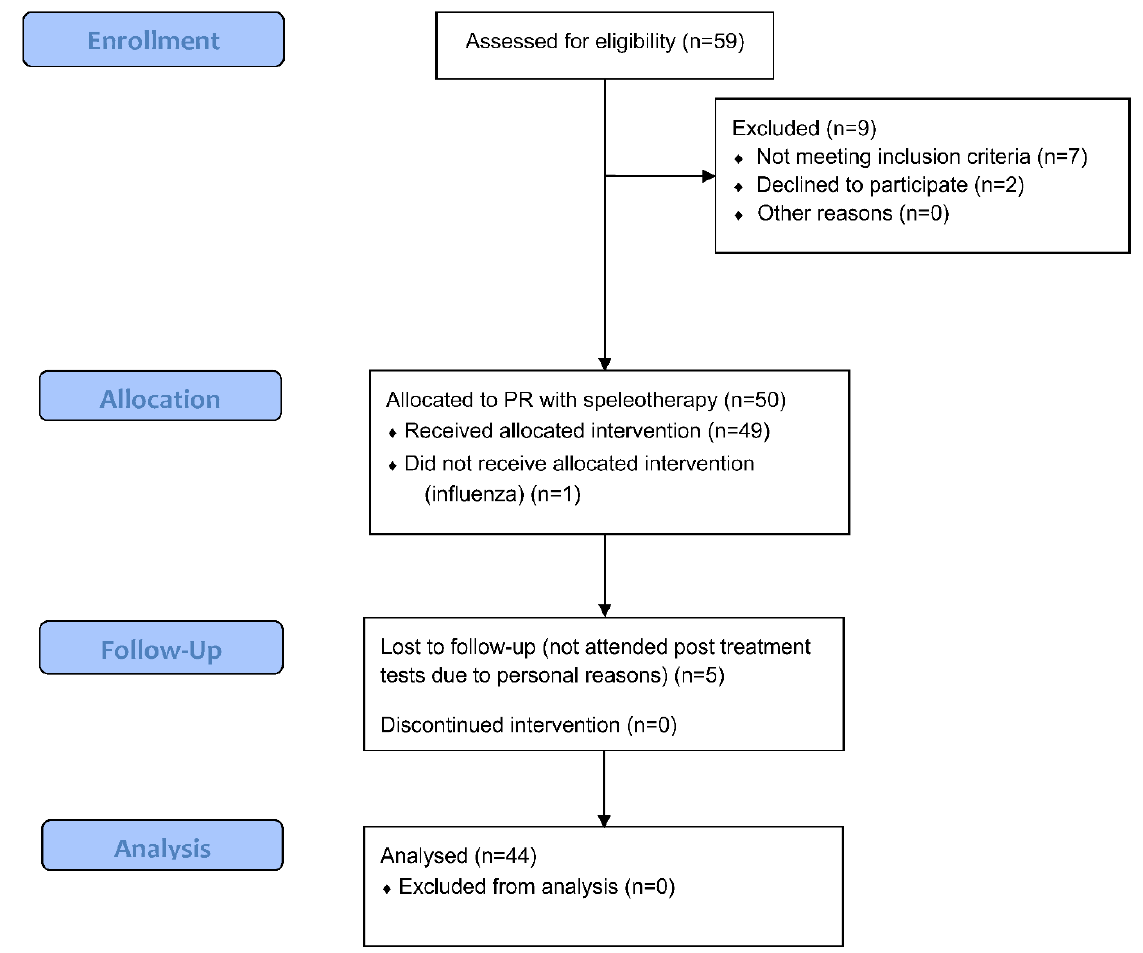
Figure 1. A flow diagram of the patients (www.consort-statement.org, accessed on 14 September 2022).